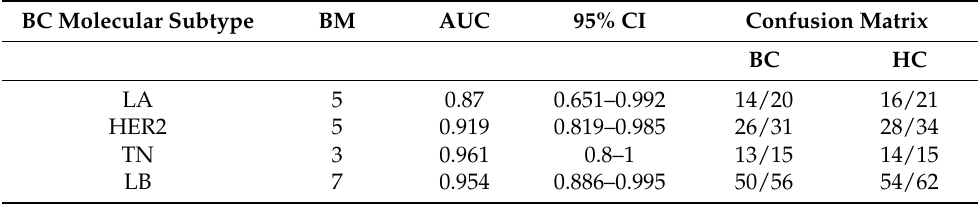
Table 2. AUC scores of selected biomarkers (BM) for the proposed models and confusion matrices of the BC subtypes.